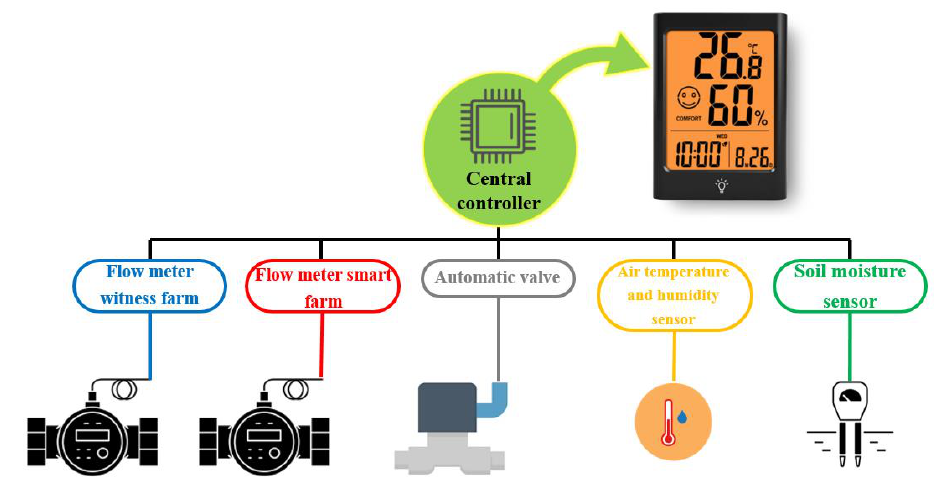
Figure 2. Overview of the intelligent system components.